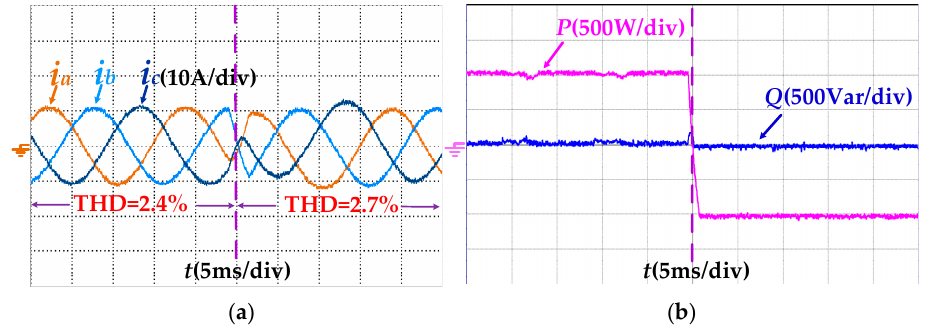
Figure 16. Experimental dynamic waveforms of proposed MPDPC with reference active power steps